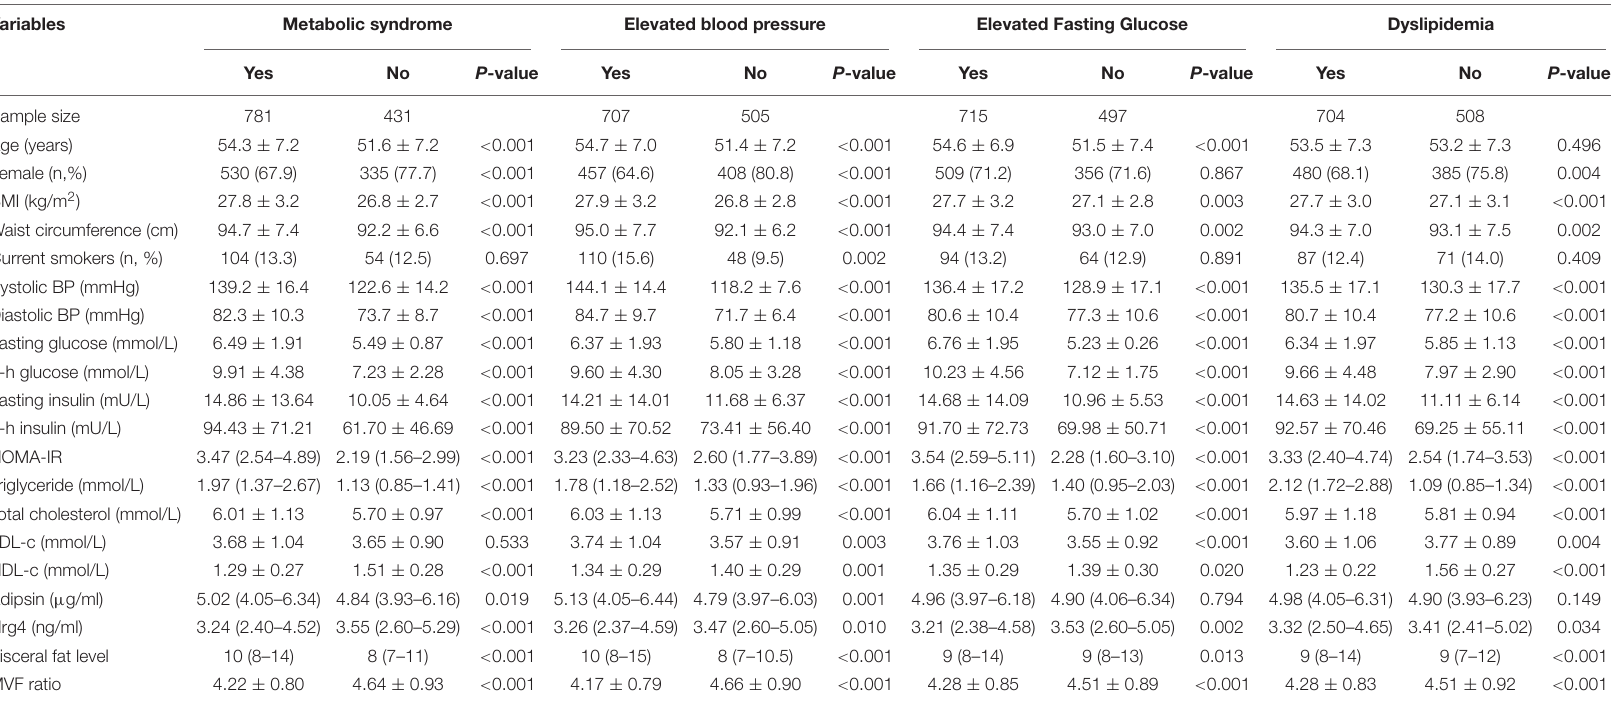
TABLE 1 | Characteristics of obese subjects according to components of metabolic